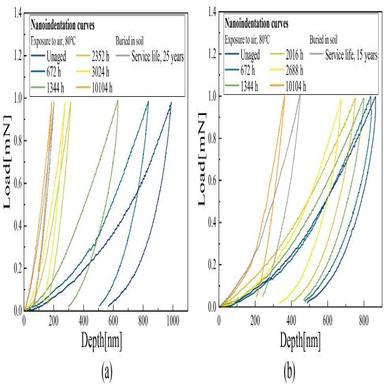
Effect of aging time on load-depth curve of outer surface of PE80 (a) and PE100 (b) pipe.